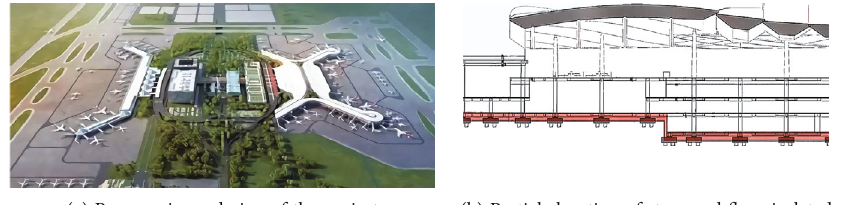
Figure 1: Haikou Meilan Airport.